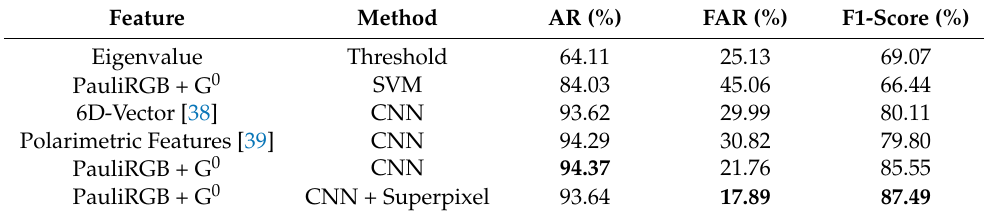
Table 3. Different methods of building extraction effects under RADARSAT-2